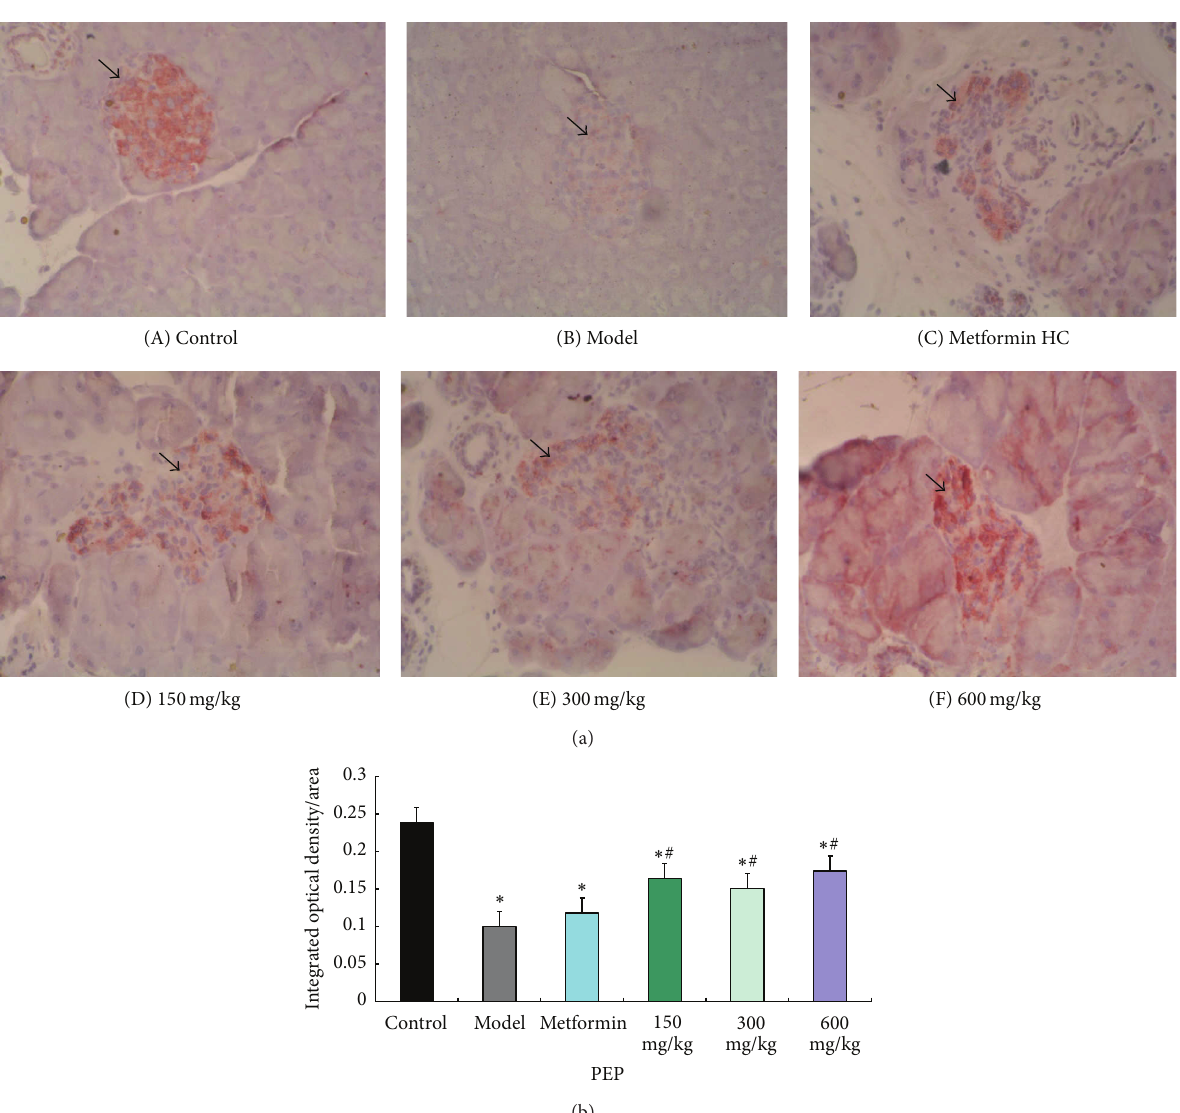
Figure 4: The effect of PEP on the histopathological structure of the pancreas in DM rats (IHC). A DM model was established by feeding rats a high-fat diet and injecting them with a low dose of STZ. After the model was established, PEP (0, 150, 300, and 600 mg/kg) was administered intragastrically as an intervention for 28d ( 𝑛 = 10 rats). The pancreatic tissues were collected, embedded, and sectioned, and a specific antibody against insulin/proinsulin was utilized to observe the residual 𝛽 -cells in islets by using immunohistochemical method (IHC). (A) control: control group; (B) model: model group; (C) metformin HC: metformin HC group; (D) 150mg/kg: low-dose PEP group; (E)300mg/kg:medium-dosePEPgroup;(F)600mg/kg:high-dosePEPgroup.Thearrowindicatesislettissue.(a)showsthehistopathological structure of the pancreas in DM rats by IHC; (b) shows the mean integrated optical density of 𝛽 -cells in islets in DM rats using the Image-Pro Plus 4.5 image analysis